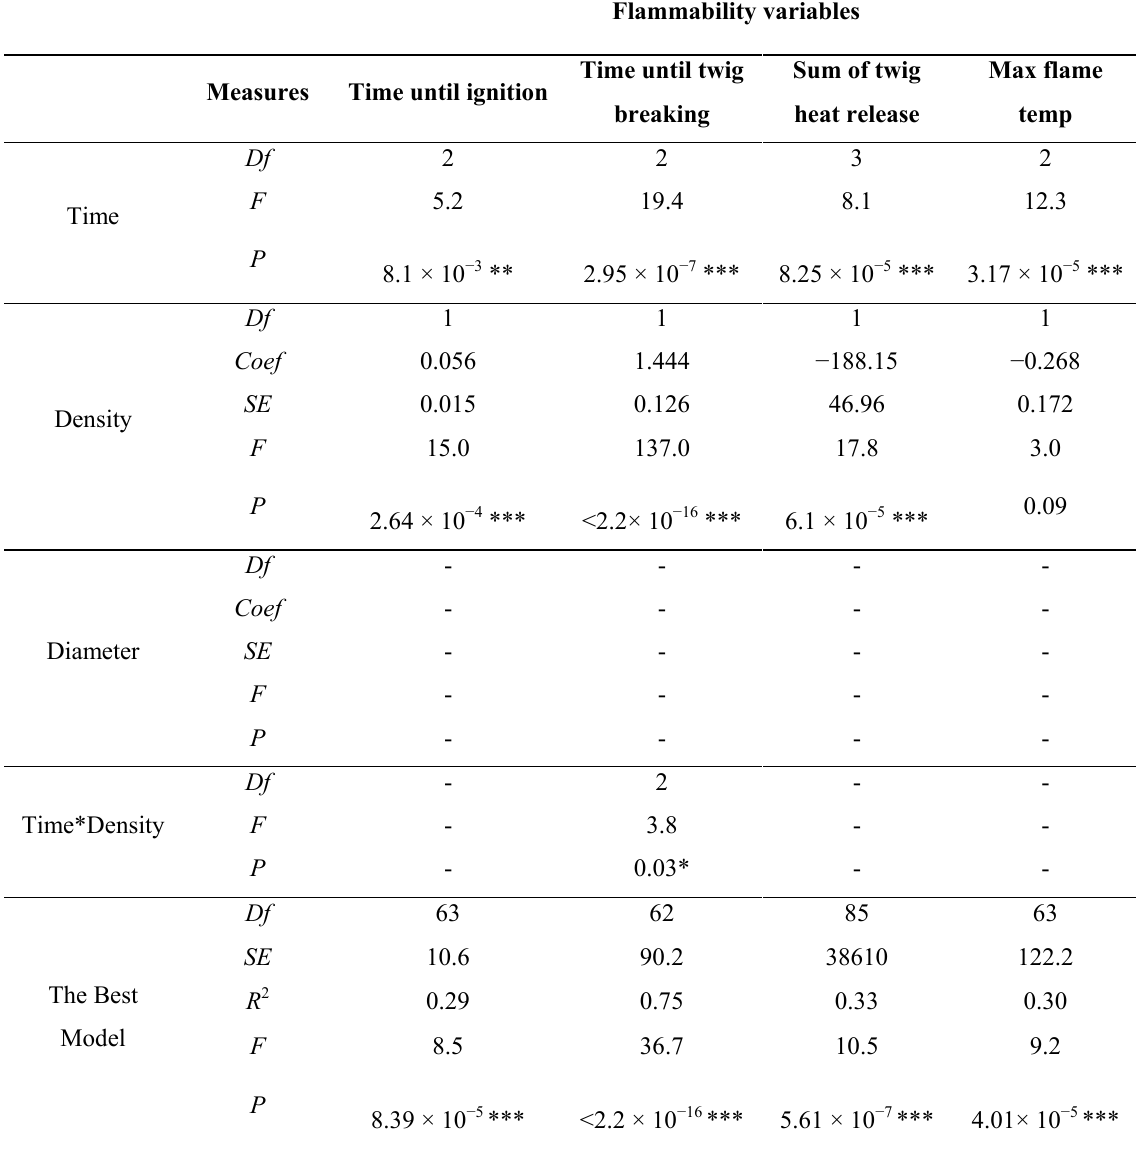
Table 2. Summary of statistics of linear models for flammability variables of Q. robur twigs during drying with time, density, and diameter as independent variables; The interaction between time and density was also taken into account; We chose the best model by Akaike information criterion (AIC) in a stepwise algorithm; The best model (the smallest AIC) does not include all factors, as it removed factors that do not contribute significantly to the